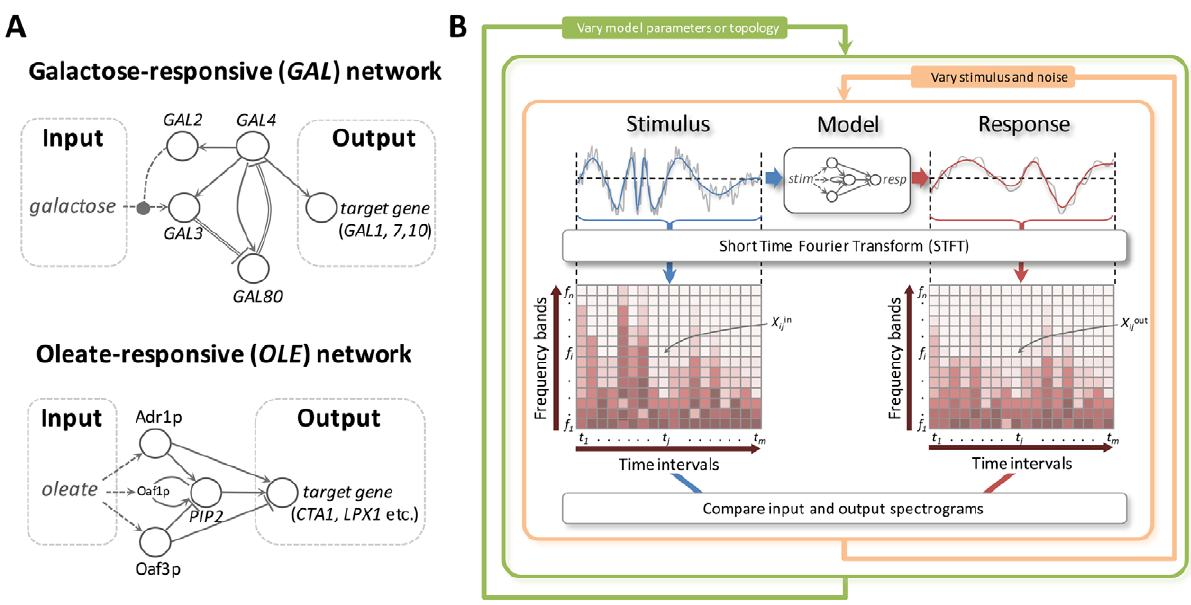
Figure 1. The generalized time-frequency analysis of the dynamical properties of molecular networks. (A) Schematic representations of the GAL (left) and OLE (right) networks. The GAL network is comprised of dual positive and negative feedback loops in which galactose activates Gal3p relieving Gal80p repression of Gal4p activity which upregulates the expression of GAL genes [11], [12]. The OLE network is comprised of overlapping positive and negative (coherent type 1 and type 2) feed-forward loops [24] in which oleate directly and indirectly activates core transcription factors (Oaf1p, Pip2p, Adr1p and Oaf3p) which regulate combinatorially target genes, such as the transcription factor PIP2 , the catalase CTA1 , the peroxisomal lipase LPX1 and others [9], [10]. Networks are displayed as interactions of genes and gene products, which are not explicitly distinguished in the illustration. Solid lines terminating in arrowheads denote positive regulation whereas lines terminating in bars denote repression. Single solid lines represent protein-DNA interactions whereas double lines denote protein-protein interactions. Dotted arrows represent activation by the metabolite. The dotted oval arrow denotes activation of galactose transport. (B) Workflow of the generalized TFA. Noisy, time varying stimuli are used as inputs to a model of the network and the response is determined. Input and output signals are transformed into component frequencies by the STFT. The contribution of each frequency band ( f i ) at time interval ( t j ) is a spectrogram coefficient ( X ij ) and is represented in the spectrogram by a color intensity. Stimuli are varied randomly in the context of systematically varying model topologies and